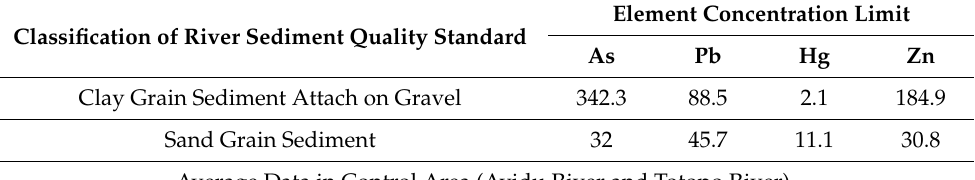
Table 6. I geo by Using Average Data in Control Area (Ayidu River and Totopo River) [19–21]. Classification of River Sediment Quality